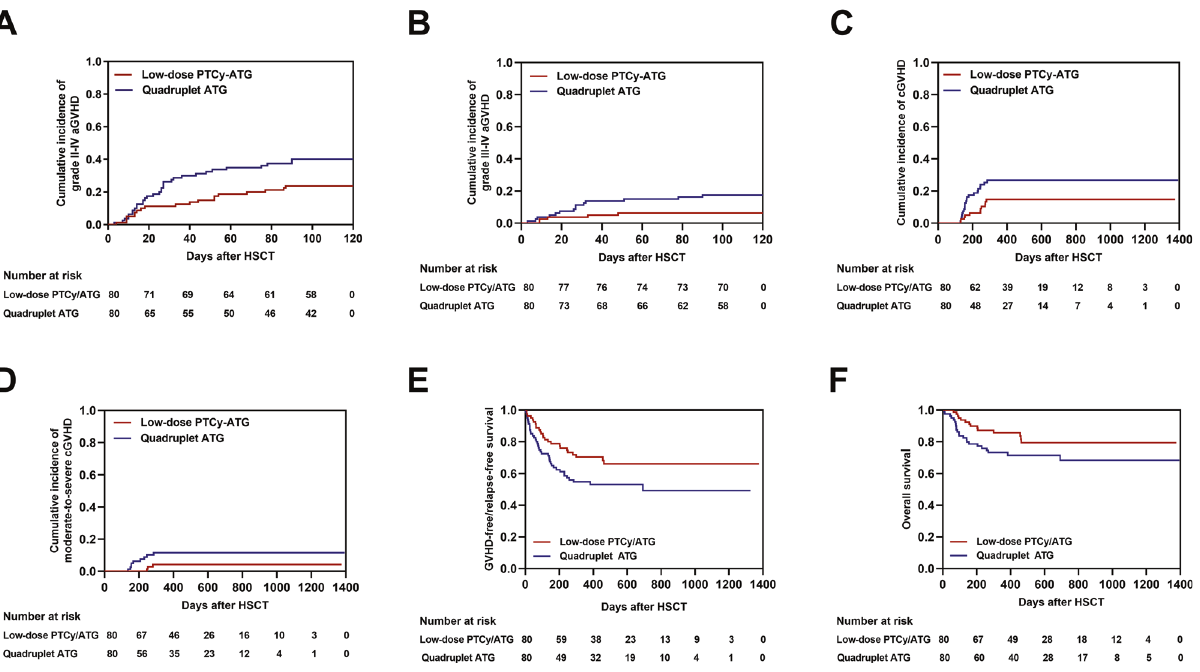
Fig. 1 Cumulative incidences (CIs) of graft-versus-host-disease (GVHD) and clinical outcomes between low-dose post-transplant cyclophosphamide (PTCy) combined with low-dose anti-thymocyte globulin (ATG) and quadruplet ATG cohorts. A The CI of grade II – IV acute GVHD (aGVHD); B The CI of grade III – IV aGVHD; C The 2-yaer CI of chronic GVHD (cGVHD); D The 2-yaer CI of moderate to severe cGVHD; E The 2-yaer CI of GVHD-free, relapse-free survival (GRFS); F The 2-yaer probability of overall survival